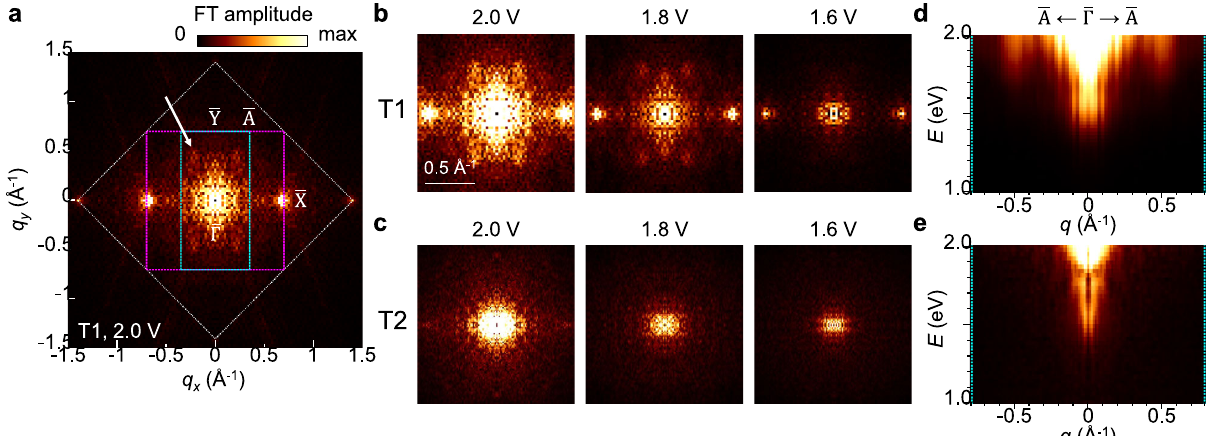
Fig. 6 QPI comparison of the two terminations. a An example QPI map from the FFT of the STS map (T1 termination, bias 2.0 V). The reciprocal lattice is marked by white dotted line, and Brillouin zones of 1 × 1 and 2 × 1 lattices are marked by purple and cyan dotted lines, respectively. b , c QPI maps at three different biases for T1 and T2 termination, respectively. d , e Energy vs. QPI signal in Γ - A direction for T1 and T2 termination,